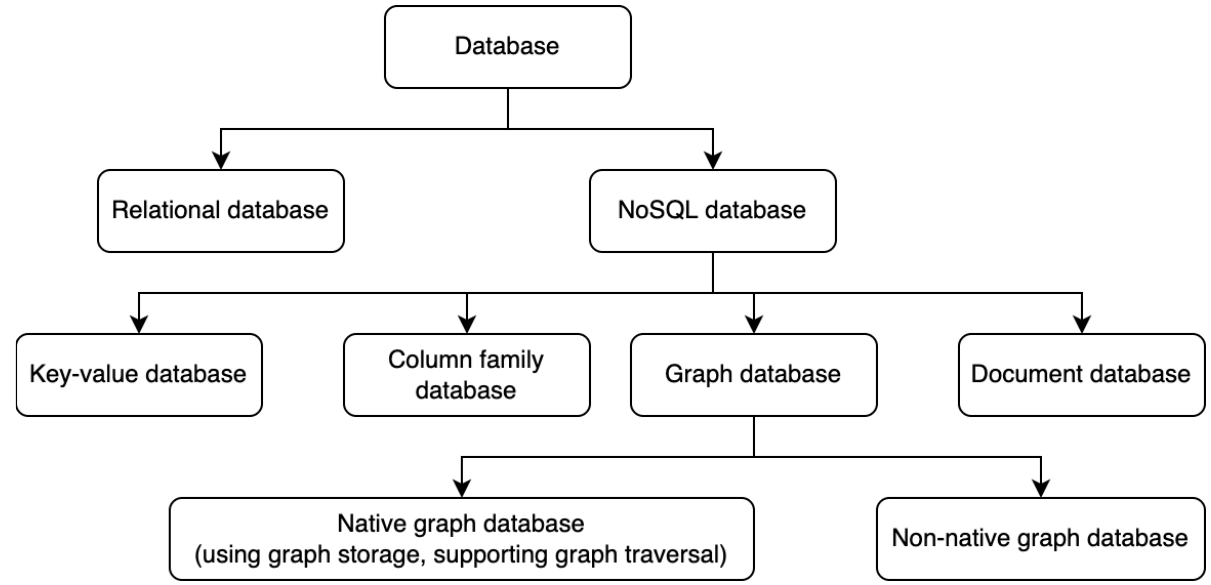
Figure 7. Types of databases and their relationship.